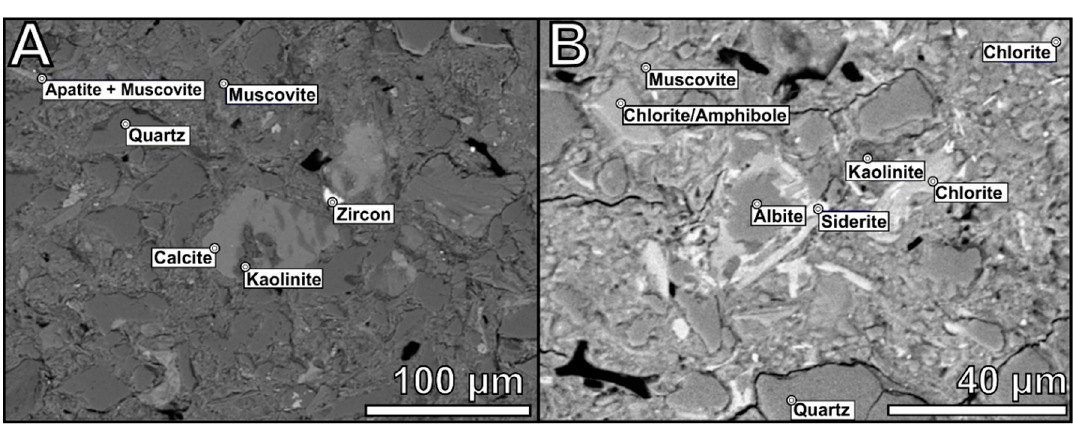
Figure 5. SEM imaging of Rurikfjellet Shale samples from 308 m depth ( A ) and another from 369 m depth ( B ) (modified after [38]).